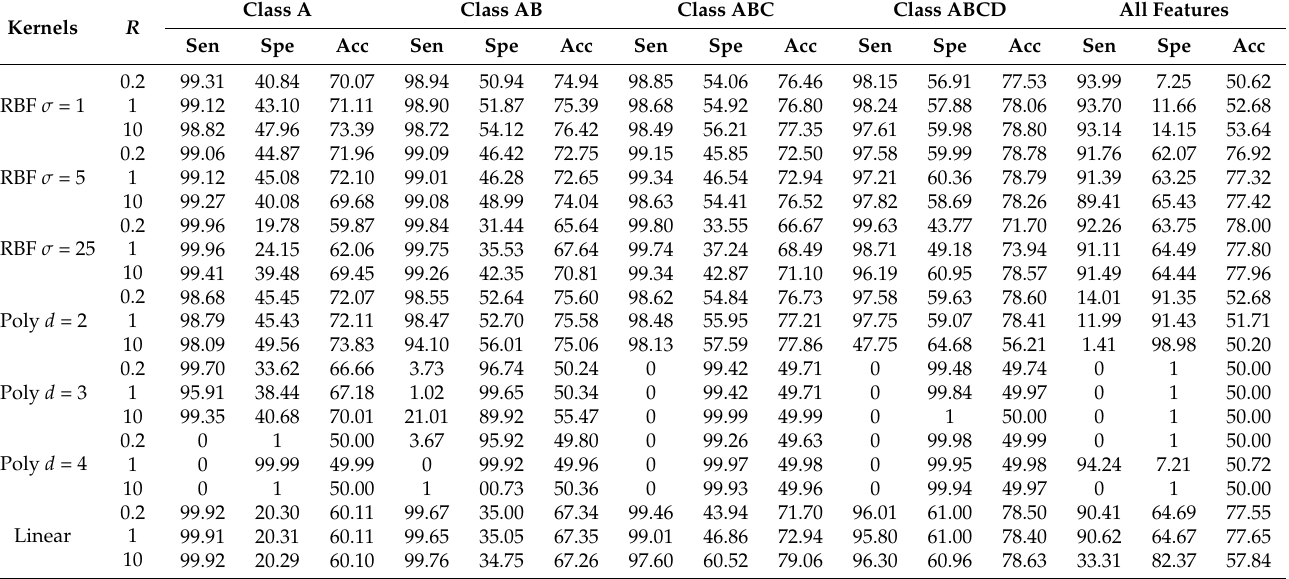
Table 4. Sensitivity (%), specificity (%), and accuracy (%) based on the hill-climbing method using SVM models with different kernel functions and parameters in the experiment with event